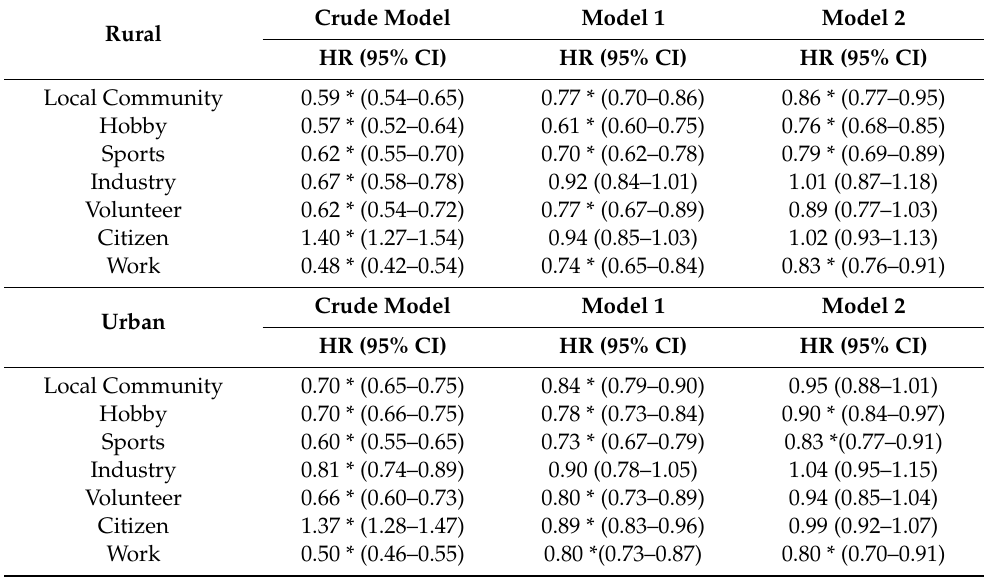
Table 3. HRs for type of social participation (reference: nonparticipation in each organization). Crude Model Model Rural